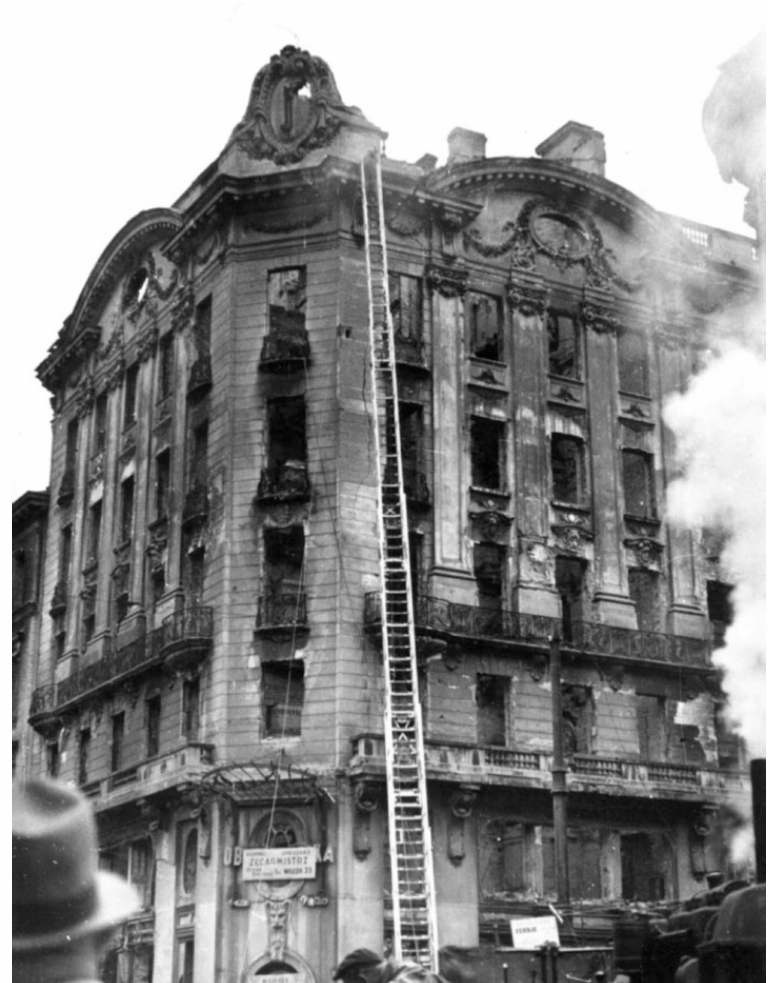
Figure 5. Demolition of burned out buildings after the war, Warsaw, 1945–1946 (Narodowe Archiwum Cyfrowe, public domain) after [24] (plate